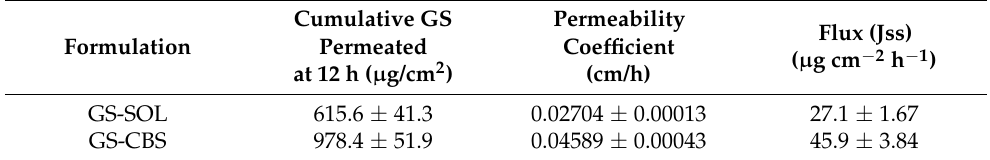
Figure 6. Ex vivo permeation profiles of GS from GS-CBS and GS-SOL. Table 4. Ex vivo permeation parameters of GS-SOL and